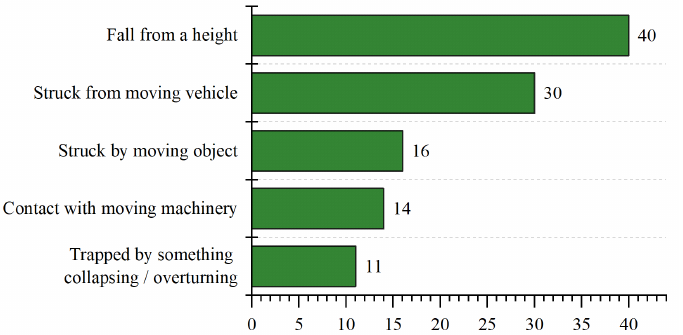
Figure 1. Main kinds of fatal accident for workers in 2018/19 in the UK [3].